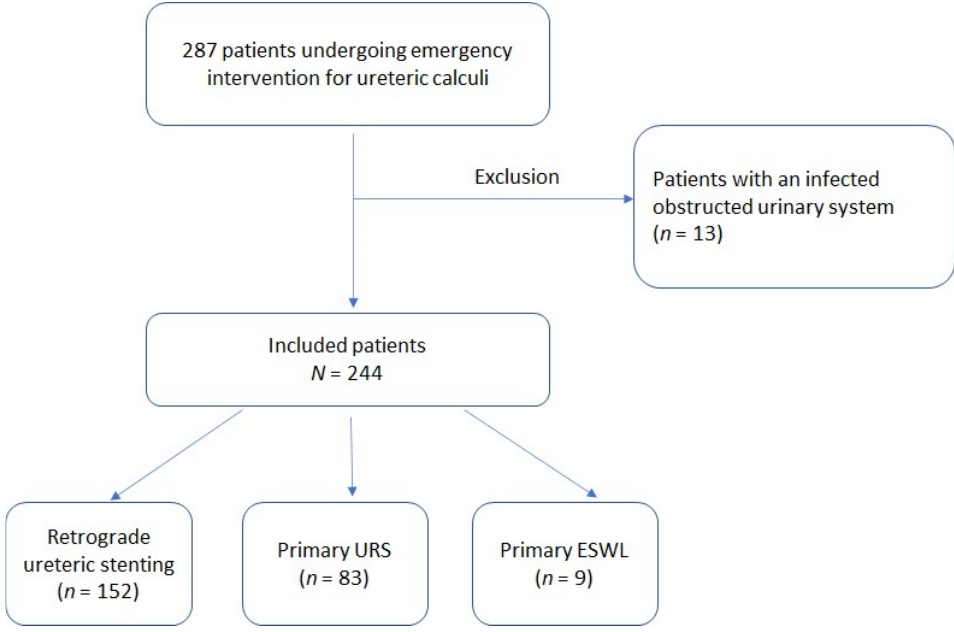
Figure 1. Flowchart demonstrating inclusion and exclusion criteria for the present study.